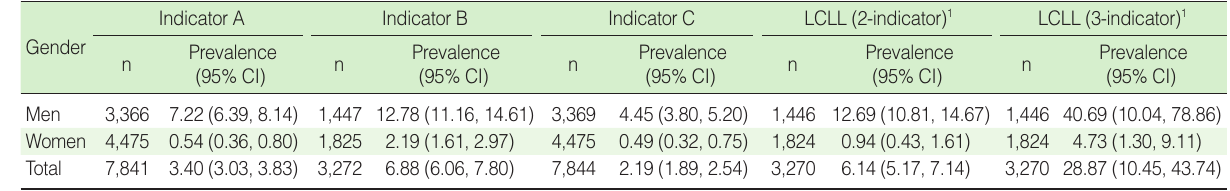
Table 4. Comparison of prevalence (%) estimates using indicators A, B, C and the LCLL models with two and three indicators for the use of any illicit drug in the past 12 months